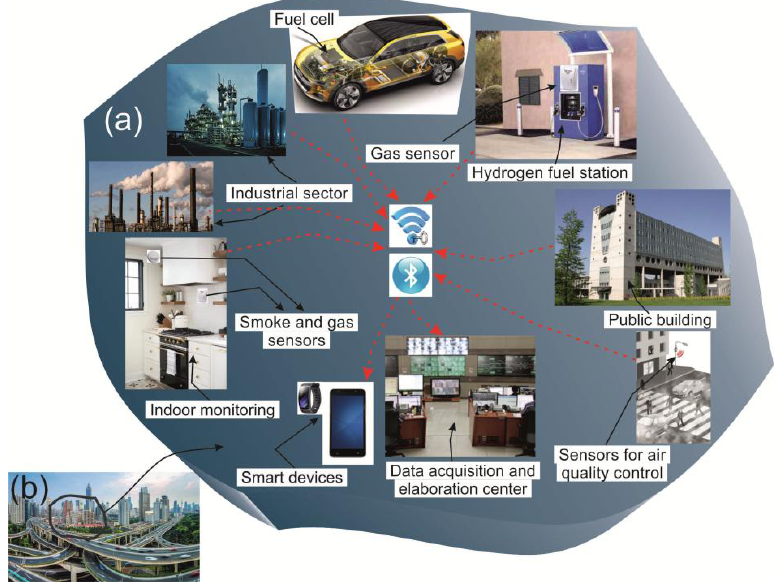
Figure 2. The schematic representation of the proposed CCS to improve the process safety and the quality of life. ( a ) represents an area of a smart city ( b ) based on the cyber home, cyber industry, cyber mobile and cyber society domains. The industrial sector, the hydrogen fuel stations, the streets, the hydrogen powered cars and the public buildings are equipped with the chemical gas sensors for the outdoor and indoor monitoring.